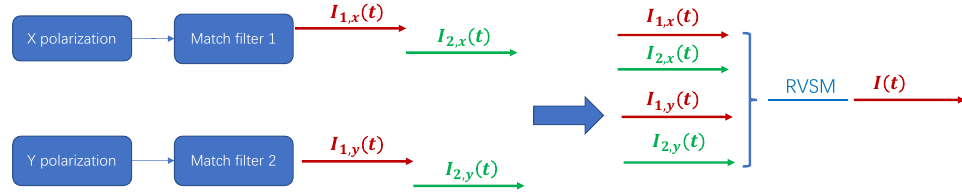
Figure 2. The space and time relationship of I 1, x ( t ) , I 1, y ( t ) , I 2, x ( t ) , I 2, y ( t ) . I 2, x ( t ) I 2, y ( t ) is 0.04 ms later than I 1, x ( t ) , I 1, y ( t ) ; we first delay the I 1, x ( t ) , I 1, y ( t ) 0.04 ms and then use the rotated vector sum method (RVSM) to synthesize the four